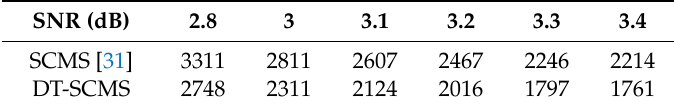
Table 3. Iterations of SCMS and DT-SCMS under di ff erent SNRs (R = 2 /